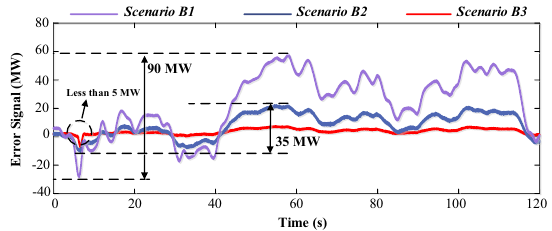
Fig. 14 The error signal e in three